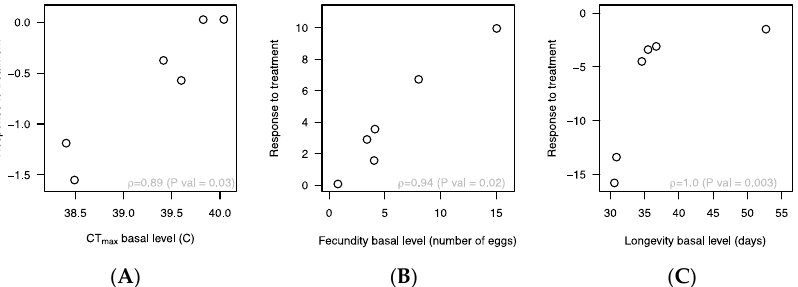
Figure 4. Trait-correlations between basal trait level (control treatment) and the phenotypic response to treatment (expressed as y control -y rapamycin , where y represent one of the three phenotypes) for CT max ( A ), fecundity ( B ) and longevity ( C ). Results are based on the within treatment line means. Spearman’s rank correlation coefficients ( ρ ) with corresponding significance levels are shown for each trait. Numbers above each point are the DGRP line IDs.